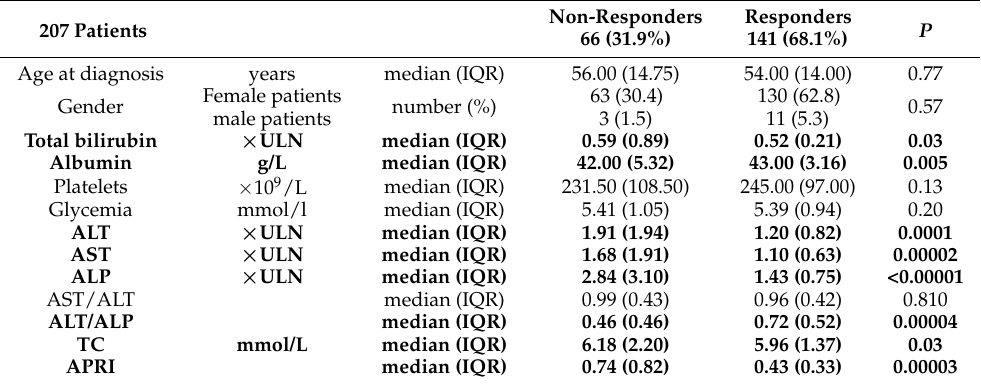
Table 2. Pretreatment differences in clinical and demographic characteristics between responders and non-responders (response evaluated after 6 months of UDCA treatment).